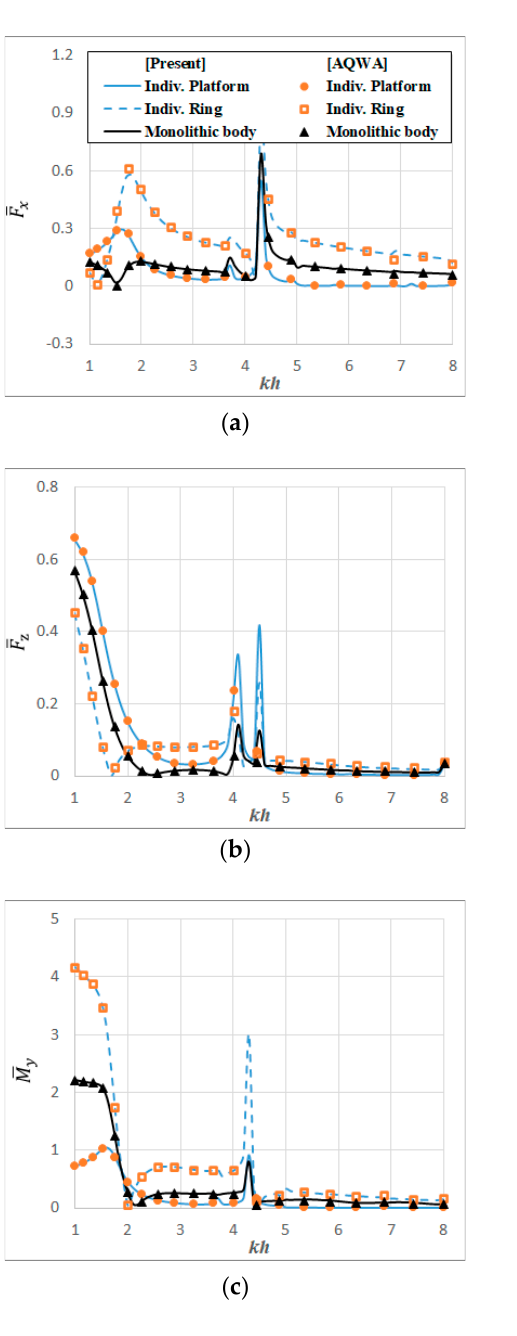
Figure 5. Comparison of wave exciting forces and RAOs obtained from AQWA and present approach: ( a ) surge force; ( b ) heave force; ( c ) pitch moment; ( d ) RAO for surge; ( e ) RAO for heave; ( f ) RAO for pitch.